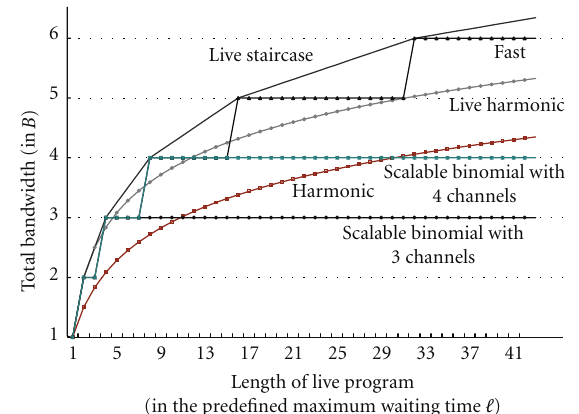
Figure 7: The required bandwidth versus the length of live